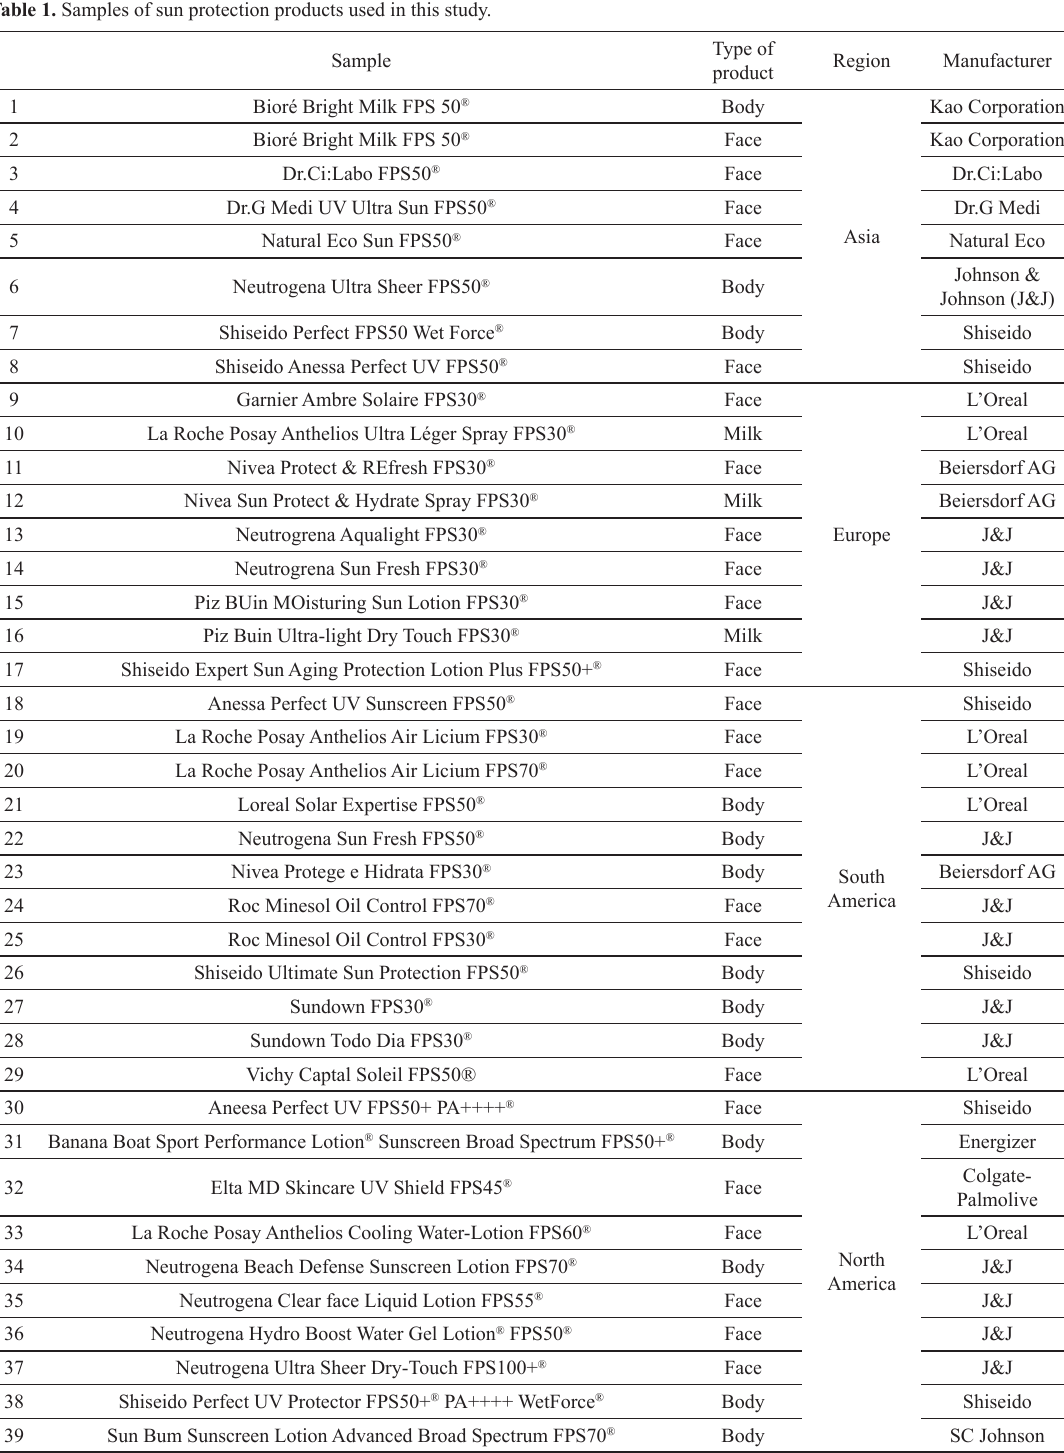
Table 1. Samples of sun protection products used in this